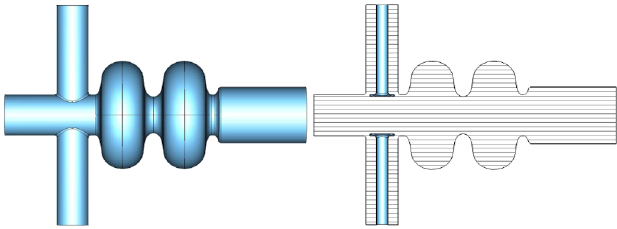
FIG. 1. MICROWAVE STUDIO model of ERL injector cavity showing the cavity exterior (left), and the cavity cross section and the inner conductors of the coaxial power couplers